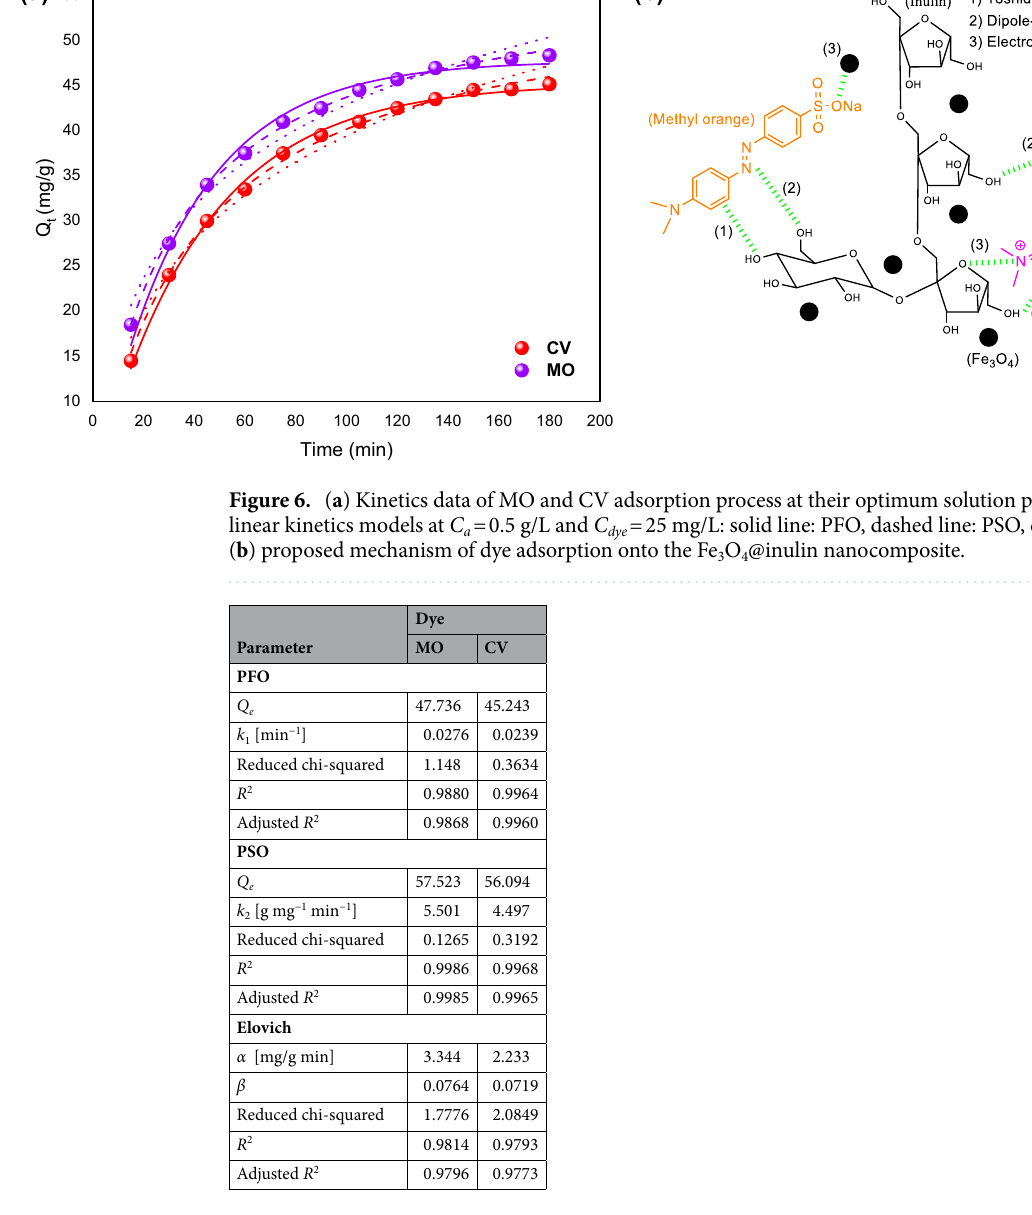
Table 2. Fitting parameters obtained from kinetics models for MO and CV adsorption onto the Fe 3 O 4 @inulin